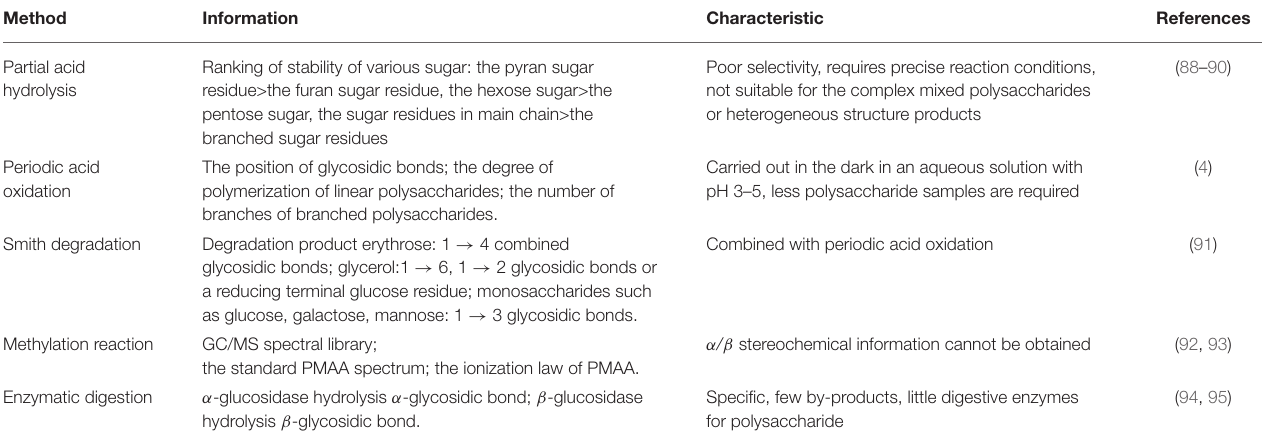
TABLE 3 | Common determination methods of glycosidic bonds of polysaccharides.